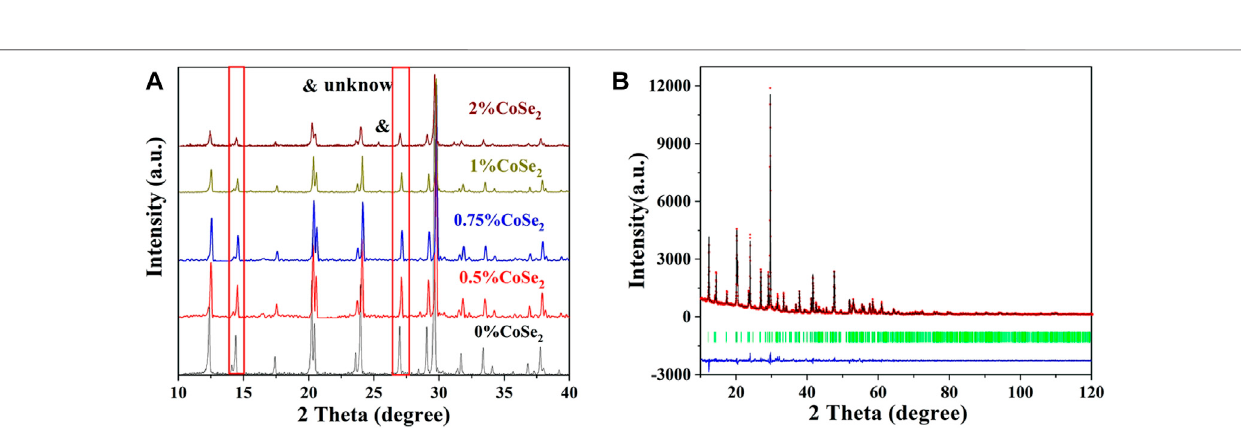
Supplementary Figure S7 . After ball milling and thermal